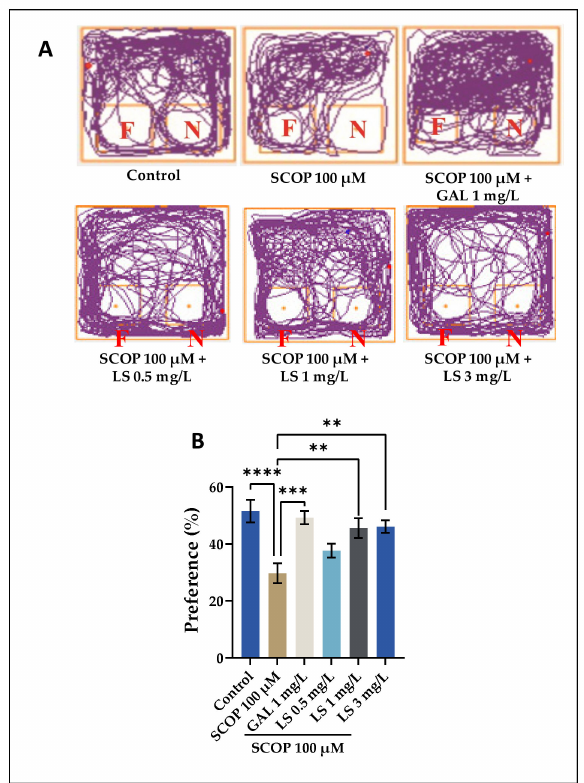
Figure 6. Lycopodium selago hydroethanolic extract (LS: 0.5, 1, and 3 mg/L) improved memory in the novel object recognition test (NOR). ( A ) Representative locomotion-tracking pattern in differ- ent groups. ( B ) Representation of the percentages of preference in different groups. Values are means ± S.E.M. ( n = 10). For Tukey’s post-hoc analyses: **** p < 0.0001, *** p < 0.001, and ** p <